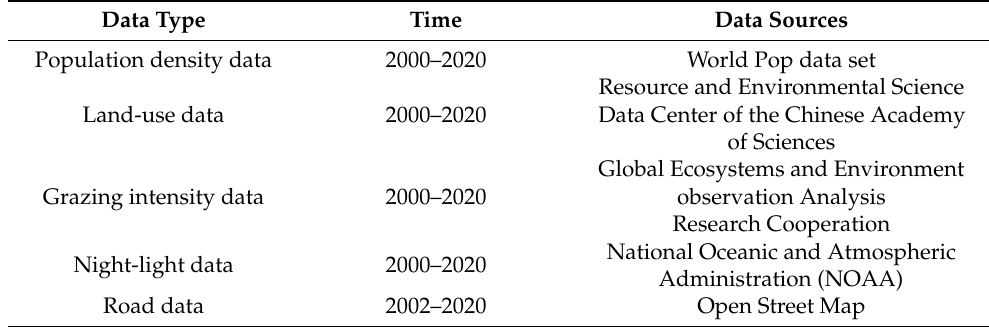
Table 1. Data source and